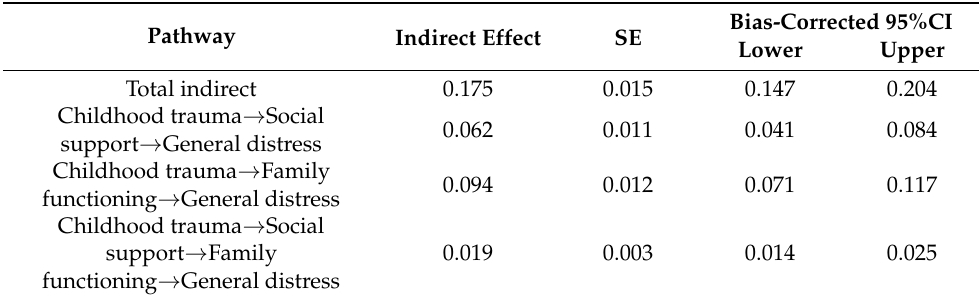
Table 4. Total, individual, and serial indirect effects for childhood trauma on general distress and bias-corrected 95% confidence intervals.